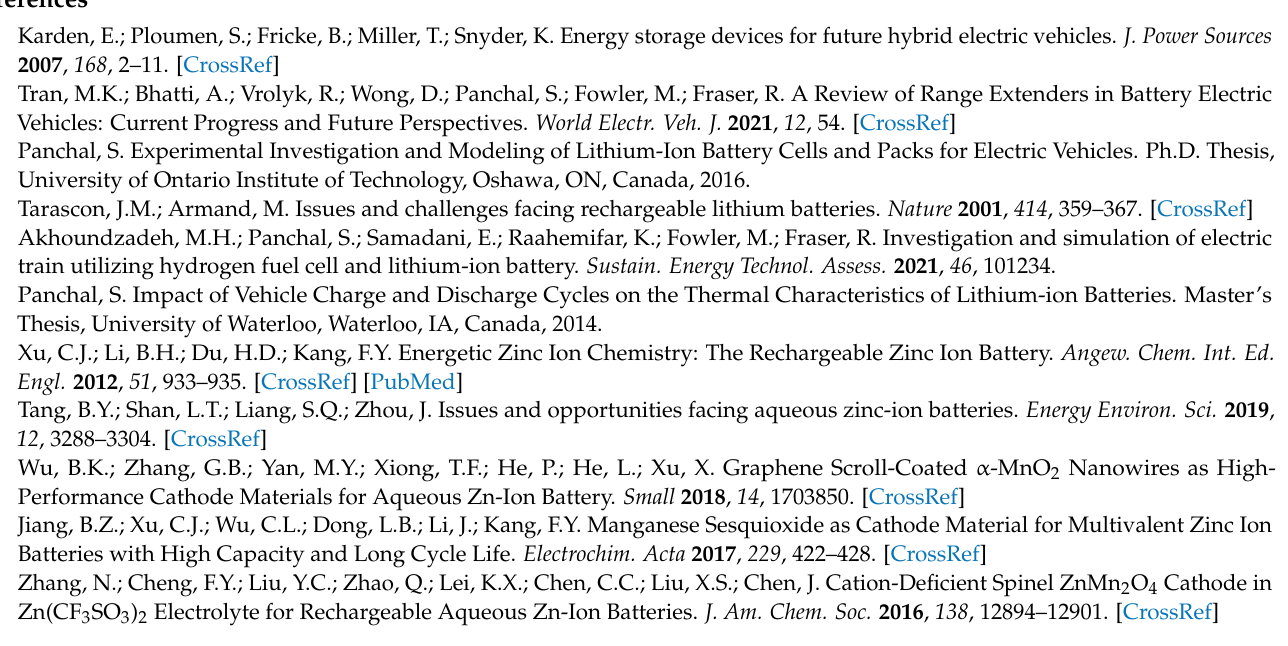
Figure S5. Charge and discharge profiles of the two LiV 3 O 8 /Zn batteries at the 100th cycle at a current density of 0.1 A g − 1 , Figure S6. Cycling stability of the hybrid batteries before and after removing oxygen at the current density of 2 A g − 1 , Figure S7. Charge and discharge profiles of the batteries using the 3 M Zn(CF 3 SO 3 ) 2 electrolyte at different current